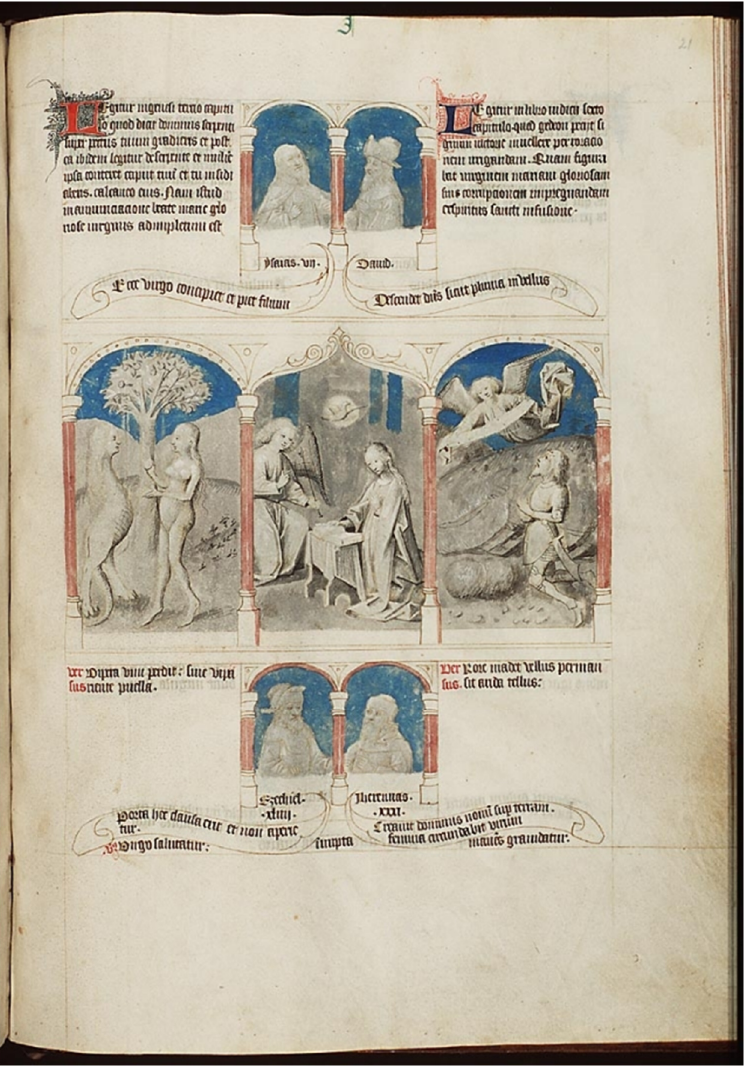
Figure 6. Master of Rambures, Biblia pauperum (Hesdin or Amiens), ca. 1450–1455. Parchment, 10.5 × 6.5 cm (left and right miniatures); 11 × 6 cm (centre miniature). Den Haag, Museum Meermanno-Westreenianum, ms 10 A 15, fol. 21r. © National Library of the Netherlands, https://manuscripts.kb.nl/zoom/BYVANCKB%3Amimi_mmw_10a15%3A021r (accessed on 30 October 2021). Image in the public domain.